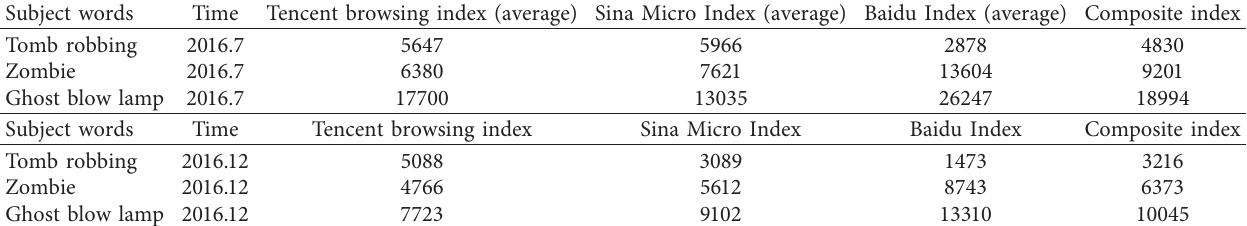
Table 3: Example of selected topic words and their external index